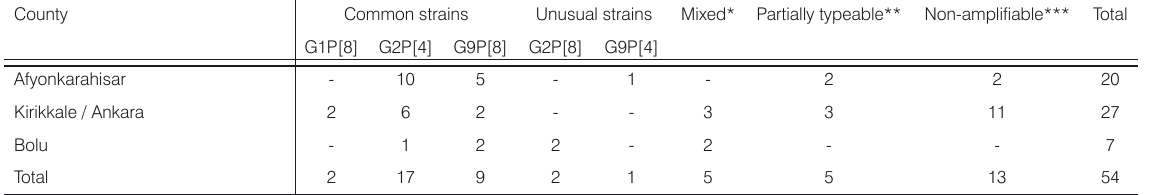
Table 2. Strain prevalence of Turkish rotavirus strains identified in Anatolia, County